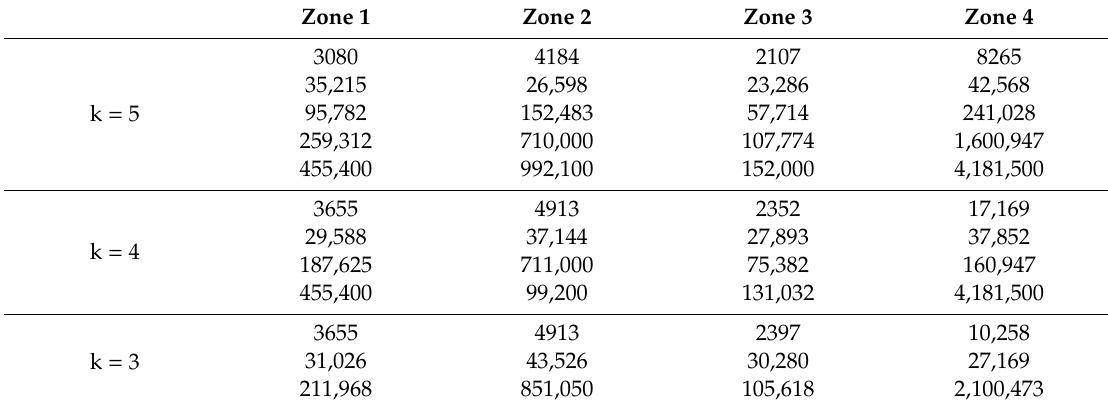
Table 3. Final burned-area centroids using k-means algorithm (m 2